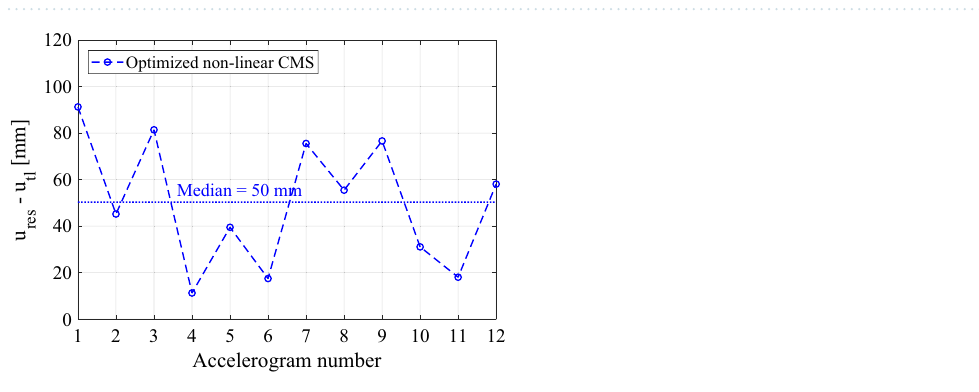
Figure 11. Maximum and median values of wire ropes for the optimized nonlinear CMS for each time